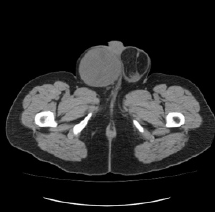
Figure 2. Baseline unenhanced CT scan showing a large right scrotal mass.